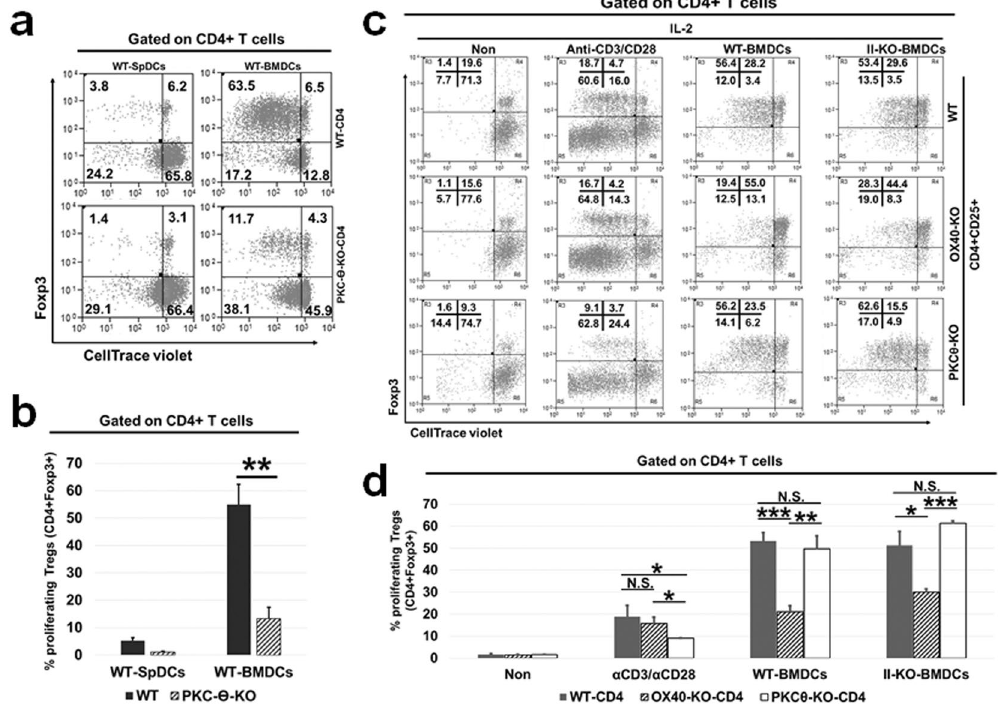
Figure 4. PKC-Ѳ-KO total CD4 + T-cells when co-cultured with WT-BMDCs showed a defect in Treg proliferation. ( a , b ) Total CD4 + T-cells were isolated from the spleens of WT and PKC-Ѳ-KO mice, CellTrace violet-labelled, then co-cultured with WT-BMDCs. Cells were harvested on day 5 and analysed by flow cytometry for Treg proliferation. ( a ) Representative dot plots ( b ) summary bar graphs of percentage of proliferating Tregs. ( c , d ) Splenic CD4 + CD25 + T-cells isolated from WT, PKCѲ-KO and OX40-KO mice, then cultured in the presence of exogenous IL-2, with microbeads coated with anti-CD3/anti-CD28 or WT/Class- II-KO-BMDCs. Cells were harvested after 4 days and analysed by flow cytometry. Dot plots ( c ) showing the proliferation of Tregs and bar graphs ( d ) representative of data shown in ( c ). Numbers shown in the dot plot is the average percentage (n = 3). Values show average ± SD, * P < 0.05, ** p < 0.005, and *** p <